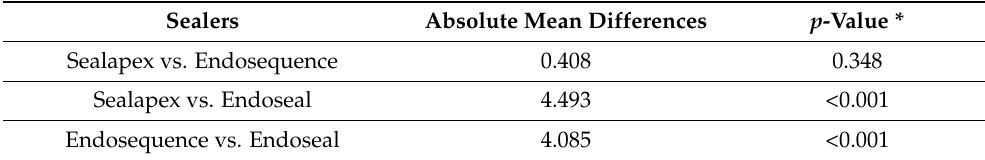
Table 2. Pairwise comparison of different endodontic sealers.